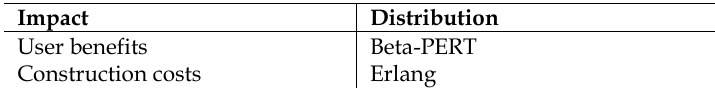
Table 1. Fitted probability distribution functions (Salling and Banister,